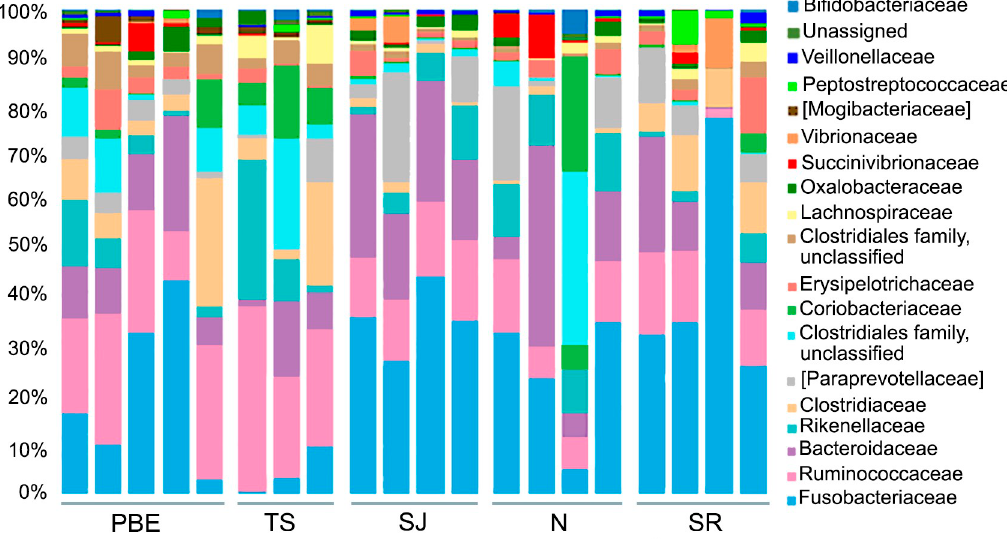
Fig 2. Composition of gut microbiota at family level. Only taxa with a > 1% relative abundance are shown. PBE = Punta Banda Estuary, TS = Todos Santos Island, SJ = San Jeronimo Island, N = Natividad Island, SR = San Roque